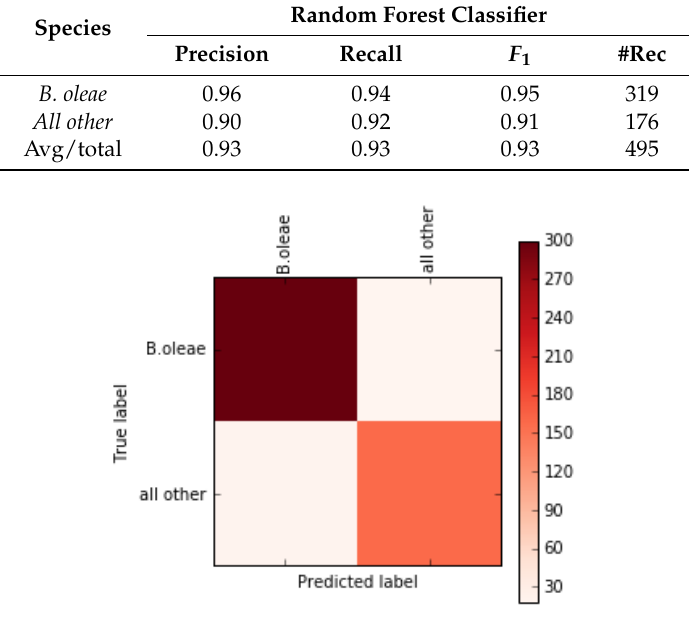
Figure 8. Confusion Matrix on a randomly selected 20% hold out set. Out of 319 cases of B. oleae 300 are classified as such and 19 are misclassified. From 176 cases of non-target fruit flies (i.e., C. capitata , L. aristella, Drosophila ) 154 cases are correctly classified as non-target whereas 22 cases are False